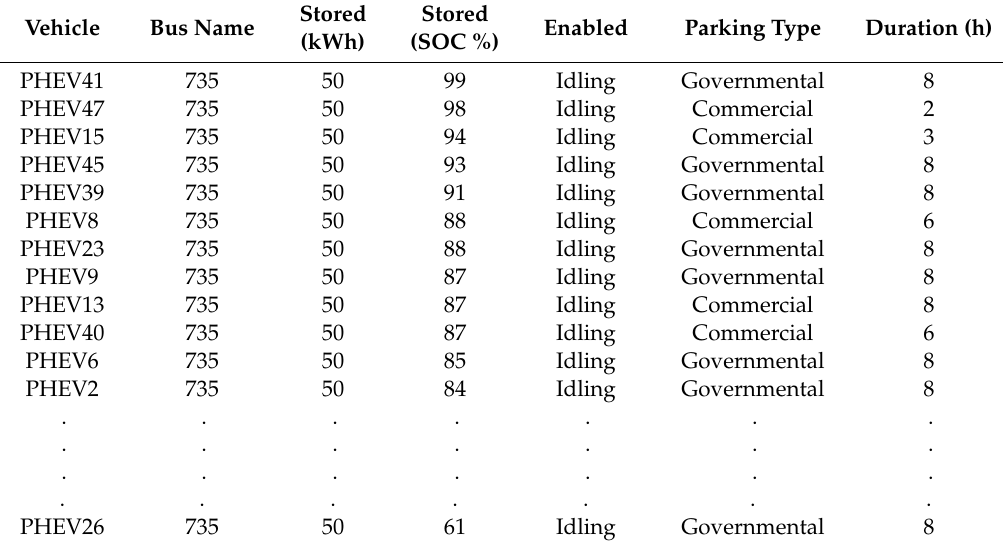
Table 4. PHEV storage discharging